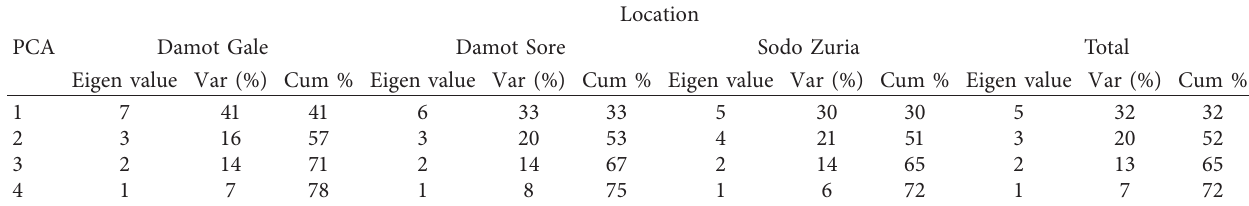
Table 1: Eigen value and explained variances of PCA for the study districts in Ethiopia during